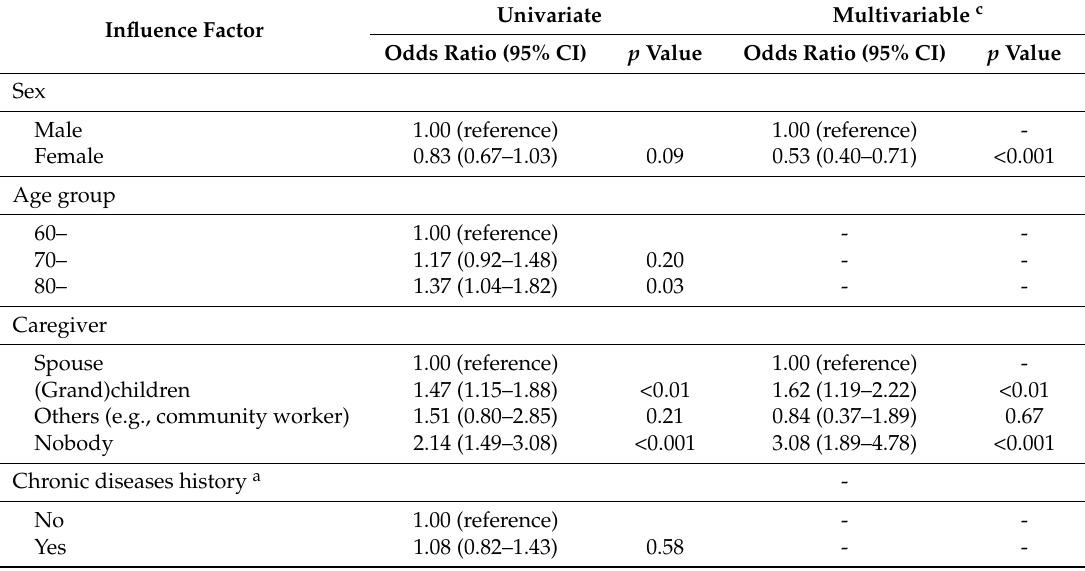
Table 3. Factors influencing the GP contract service signing decision by univariate and multivariable logistic regression